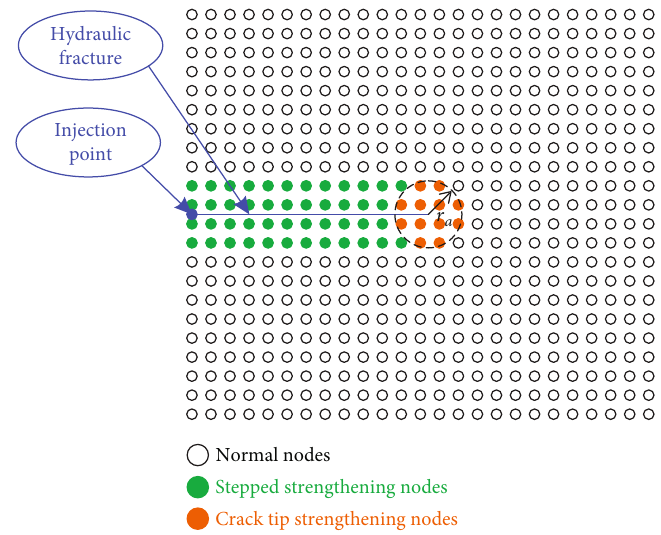
Figure 4: Treatment of nodes near cracks.